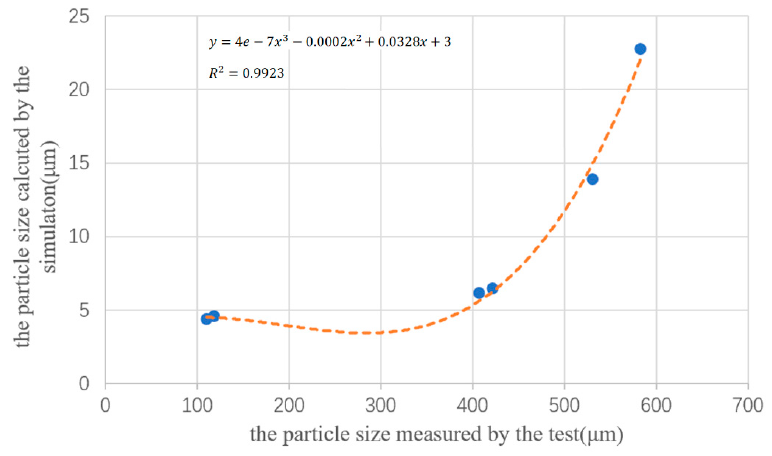
Figure 11. Modification relationship between simulation and tested particles. 13 of 15 The correction formula was 18 cm away from the nozzle outlet. In order to make the formula suitable for 30 cm or other planes (jet state, no collision, less affected by gravity, or velocity meets the atomization conditions), it was necessary to determine the relationship between the simulated atomization particle size between the two target surfaces [26–28]. The results are shown in Figure 12. The x -axis refers to the experimental particle data at 18 cm, and the y -axis refers to the simulation particle data on other target surfaces. It can be seen from Figure 11 that the modified relationship between the 18 cm test data (abscissa x ) and simulation data (ordinate y ) was: